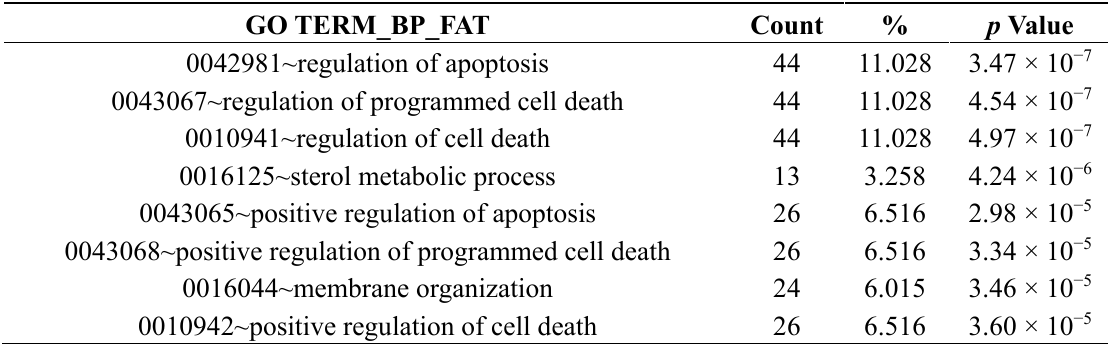
Table 1. Genes of GO functional category analysis that were differentially expressed in 95D cells after c3orf1 siRNA treatment for 48 h ( p <